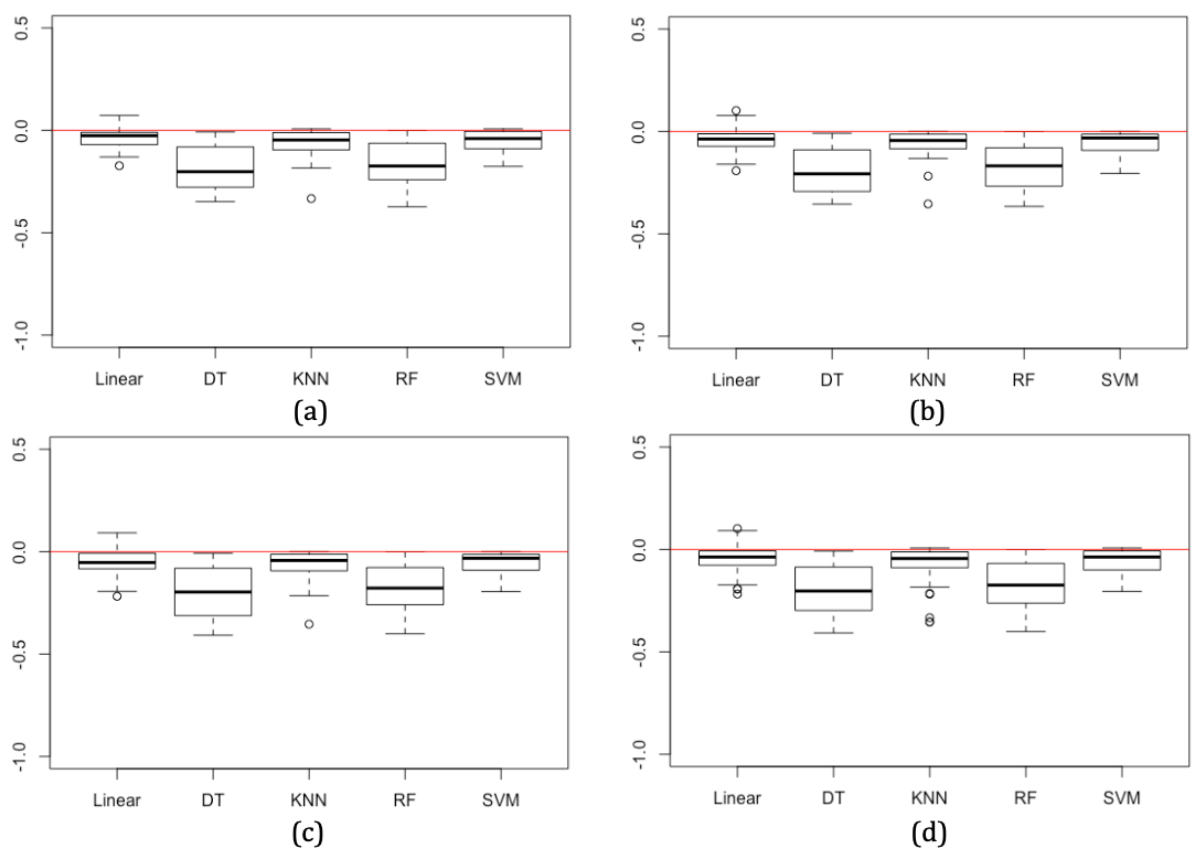
Figure 3. Overall change in accuracy for each machine learning model when trained on synthetic data across 19 datasets and 3 synthetic data approaches where classification and regression tree (a), parametric (b), Bayesian network (c), and all approaches combined (d), compared with models trained using real